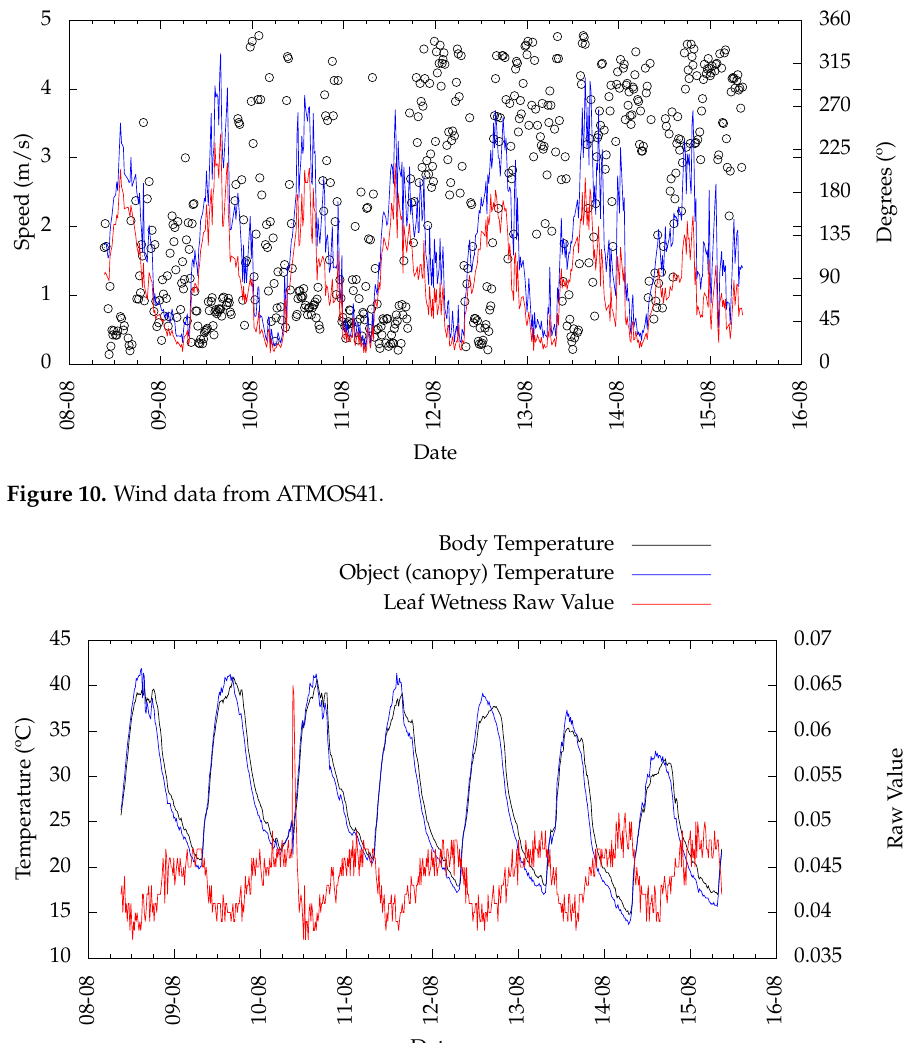
Figure 11. IR data from SIL-411 and Leaf Wetness data from PYTHOS31.